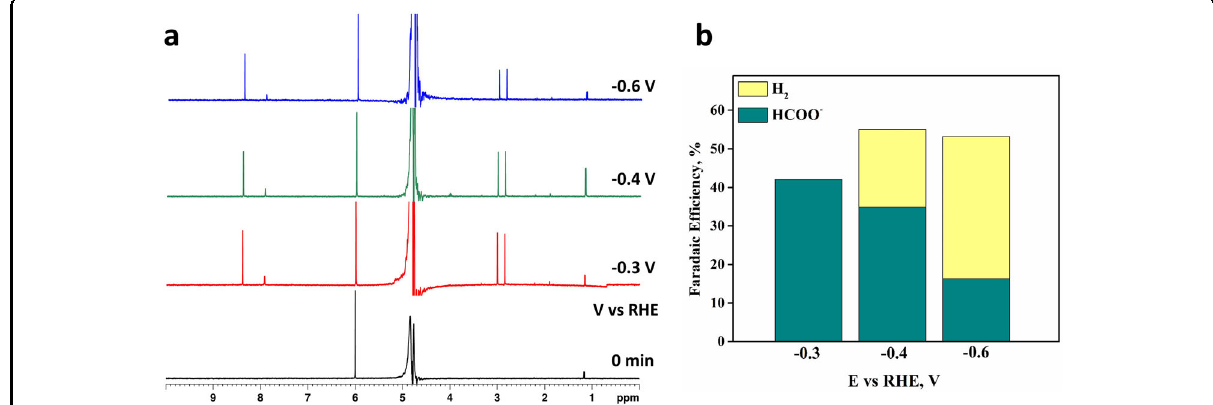
Fig. 6 Electrochemical production ef fi ciency. a 1 H NMR spectra of the electrolyte solutions subjected to different potentials (10% D 2 O was added to all samples and maleic acid was used as an internal standard). b Products formed at different potentials, as identi fi ed by NMR and GC.